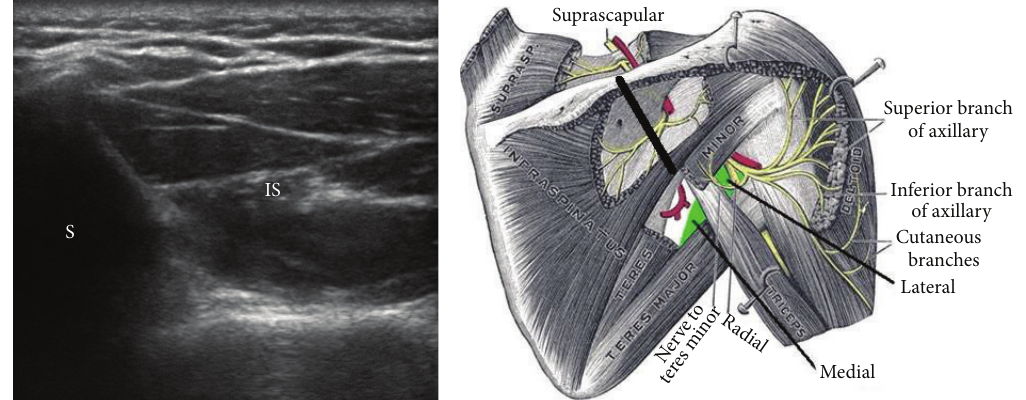
Figure 1: Shortaxis view of theinfraspinatus(IS) at thespineofthe scapula (S). Figureadapted fromthe medical gallery of Mikael Haggstrom.